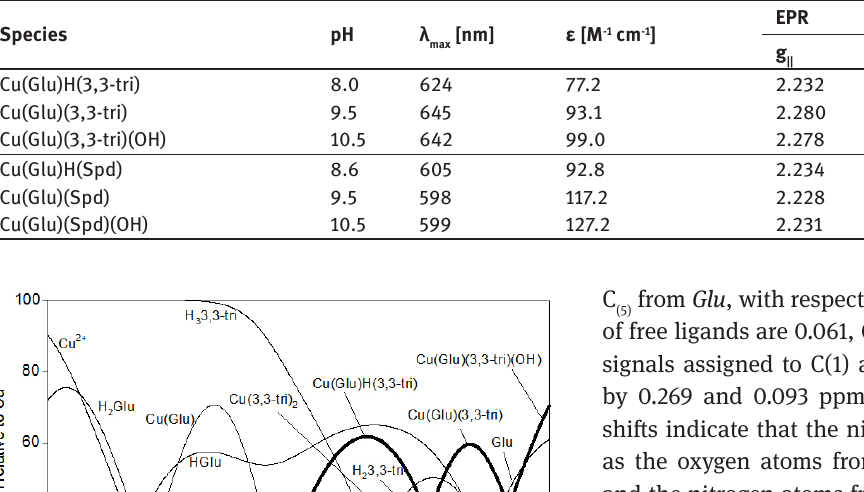
Table 4: Vis and EPR spectral data for Cu(II)/Glu/triamine systems.